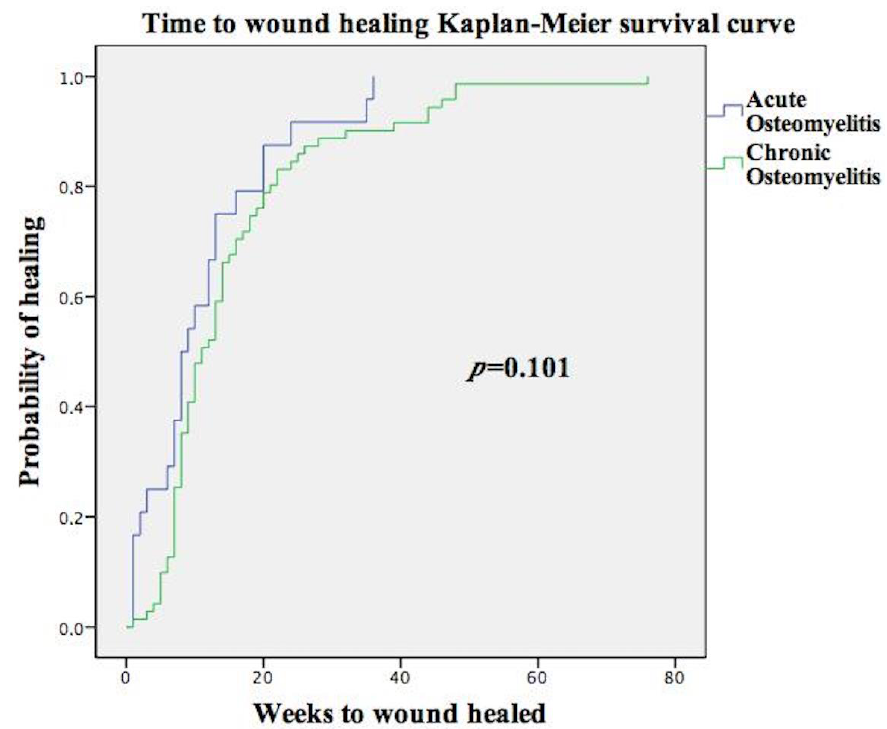
Figure 1. Kaplan-Meir survival curve of time to wound healing among patients with acute osteo- myelitis versus chronic